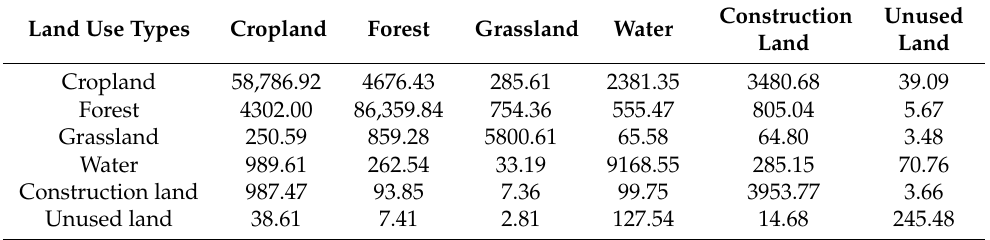
Construction Unused Land Land